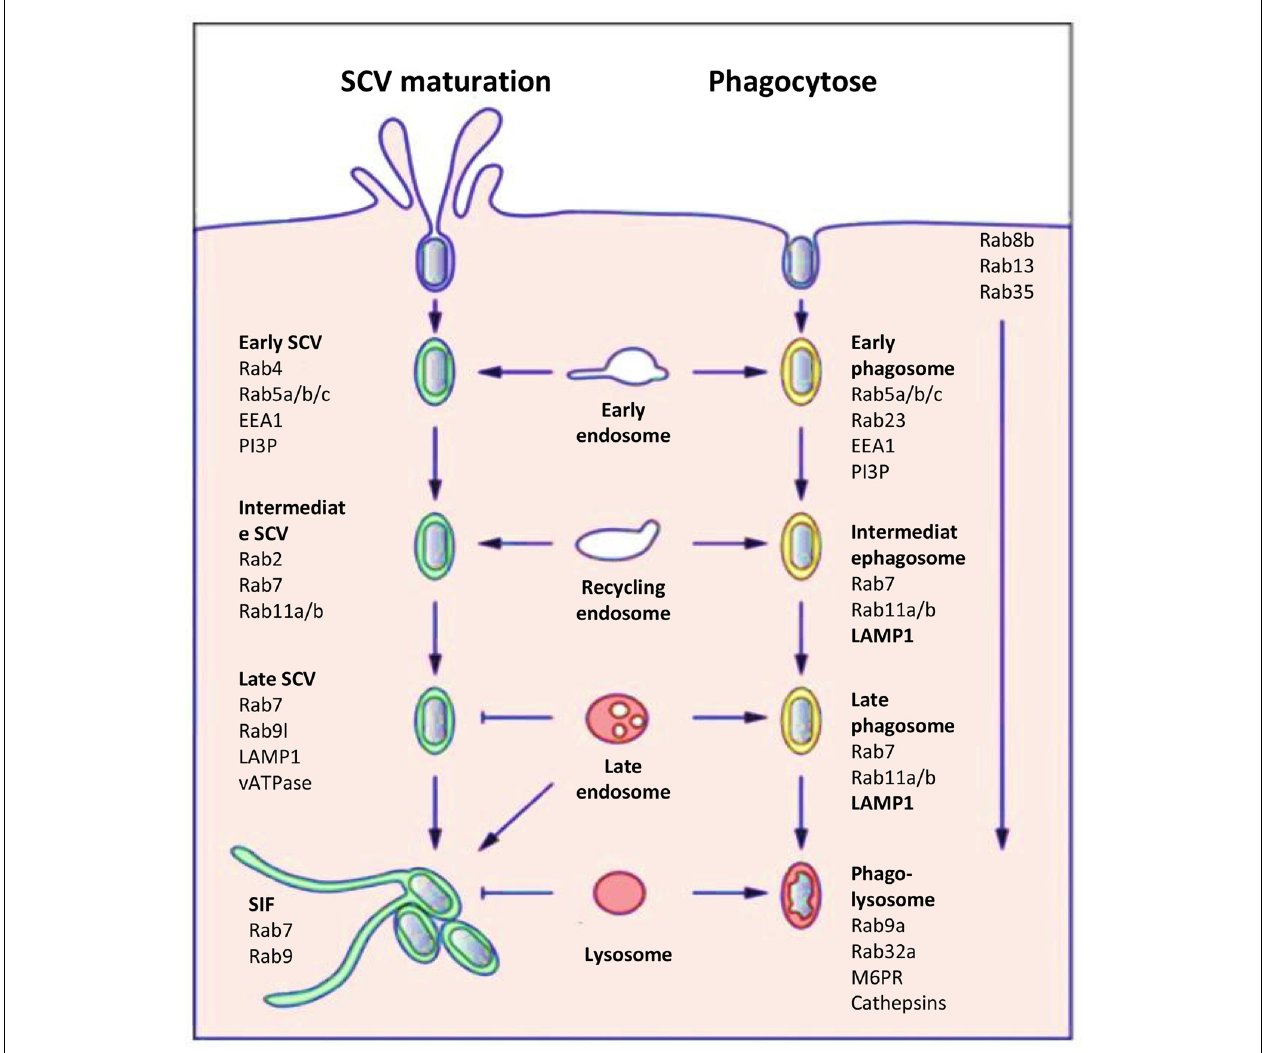
FIGURE 3 | Host cell markers present on the SCV (left) or on a phagosome (right). Comparison of the host cell markers, which characterize the classic endosome process and the biogenesis and maturation of the SCV (Figure modified from Bakowski etal., 2008).